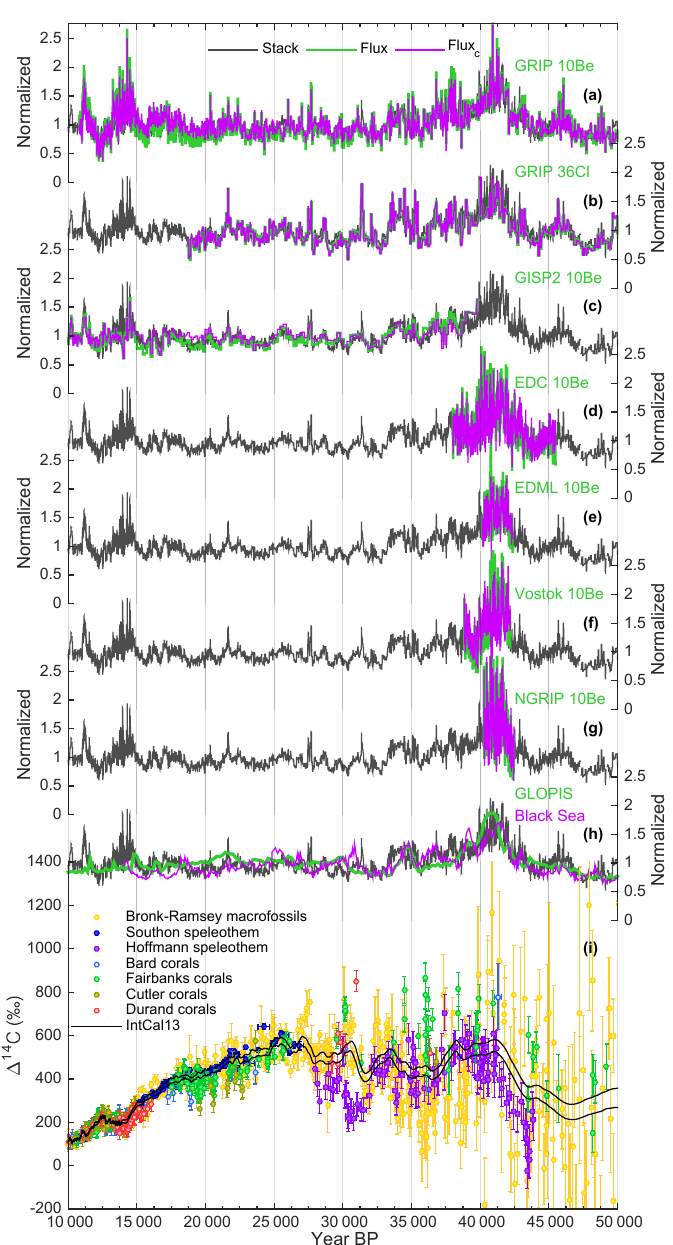
Figure 1. Data used in this study. (a–g) Individual ice-core records of GRIP 10 Be (Baumgartner et al., 1997b; Muscheler et al., 2004; Wagner et al., 2001a; Yiou et al., 1997; Adolphi et al., 2014), GRIP 36 Cl (Baumgartner et al., 1997a, 1998; Wagner et al., 2001b; Wagner et al., 2000), GISP2 10 Be (Finkel and Nishiizumi, 1997), and 10 Be from EDC, EDML, Vostok, and NGRIP (all Raisbeck et al., 2017). Each record represents deposition fluxes (green) and “climate-corrected” fluxes (purple; see text). In addition, each panel contains the stack of all ice-core records (black; see text). (h) 10 Be production rates modeled from two geomagnetic field intensity reconstructions: GLOPIS (green; Laj et al., 2004) and based on Black Sea sediments (purple; Nowaczyk et al., 2013) using the production rate model by Herbst et al. (2016). The ice-core radionuclide stack is shown in black. All records in (a–h) are shown on the GICC05 timescale (Seierstad et al., 2014) and normalized to (i.e., divided by) their mean. (i) Absolutely dated 14 C data from Lake Suigetsu (yellow; Bronk Ramsey et al., 2012), Hulu Cave (blue; Southon et al., 2012), Bahamas speleothems (purple; Hoffmann et al., 2010), and various tropical coral datasets (Bard et al., 1998; Cutler et al., 2004; Durand et al., 2013; Fairbanks et al., 2005; shown in light blue, olive, red, and green, respectively). The black lines encompass the ± 1 σ uncertainties of IntCal13 (Reimer et al.,